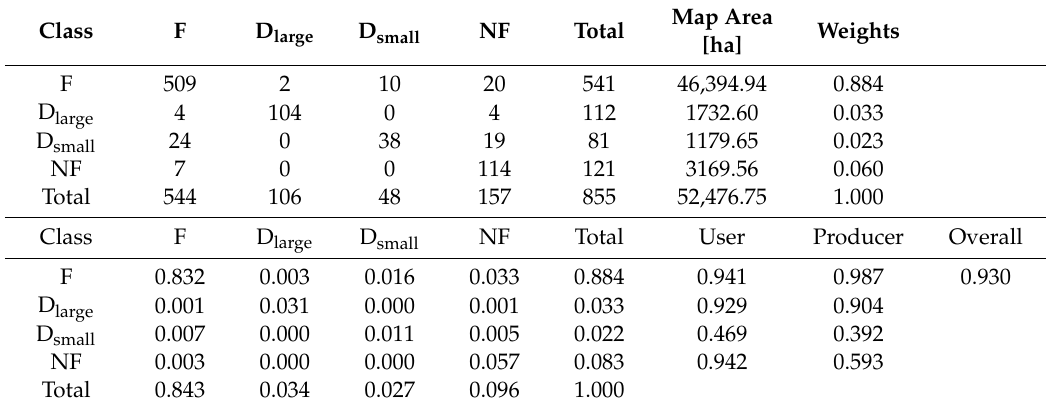
Table A11. “Union” disturbance map validation Gabon.